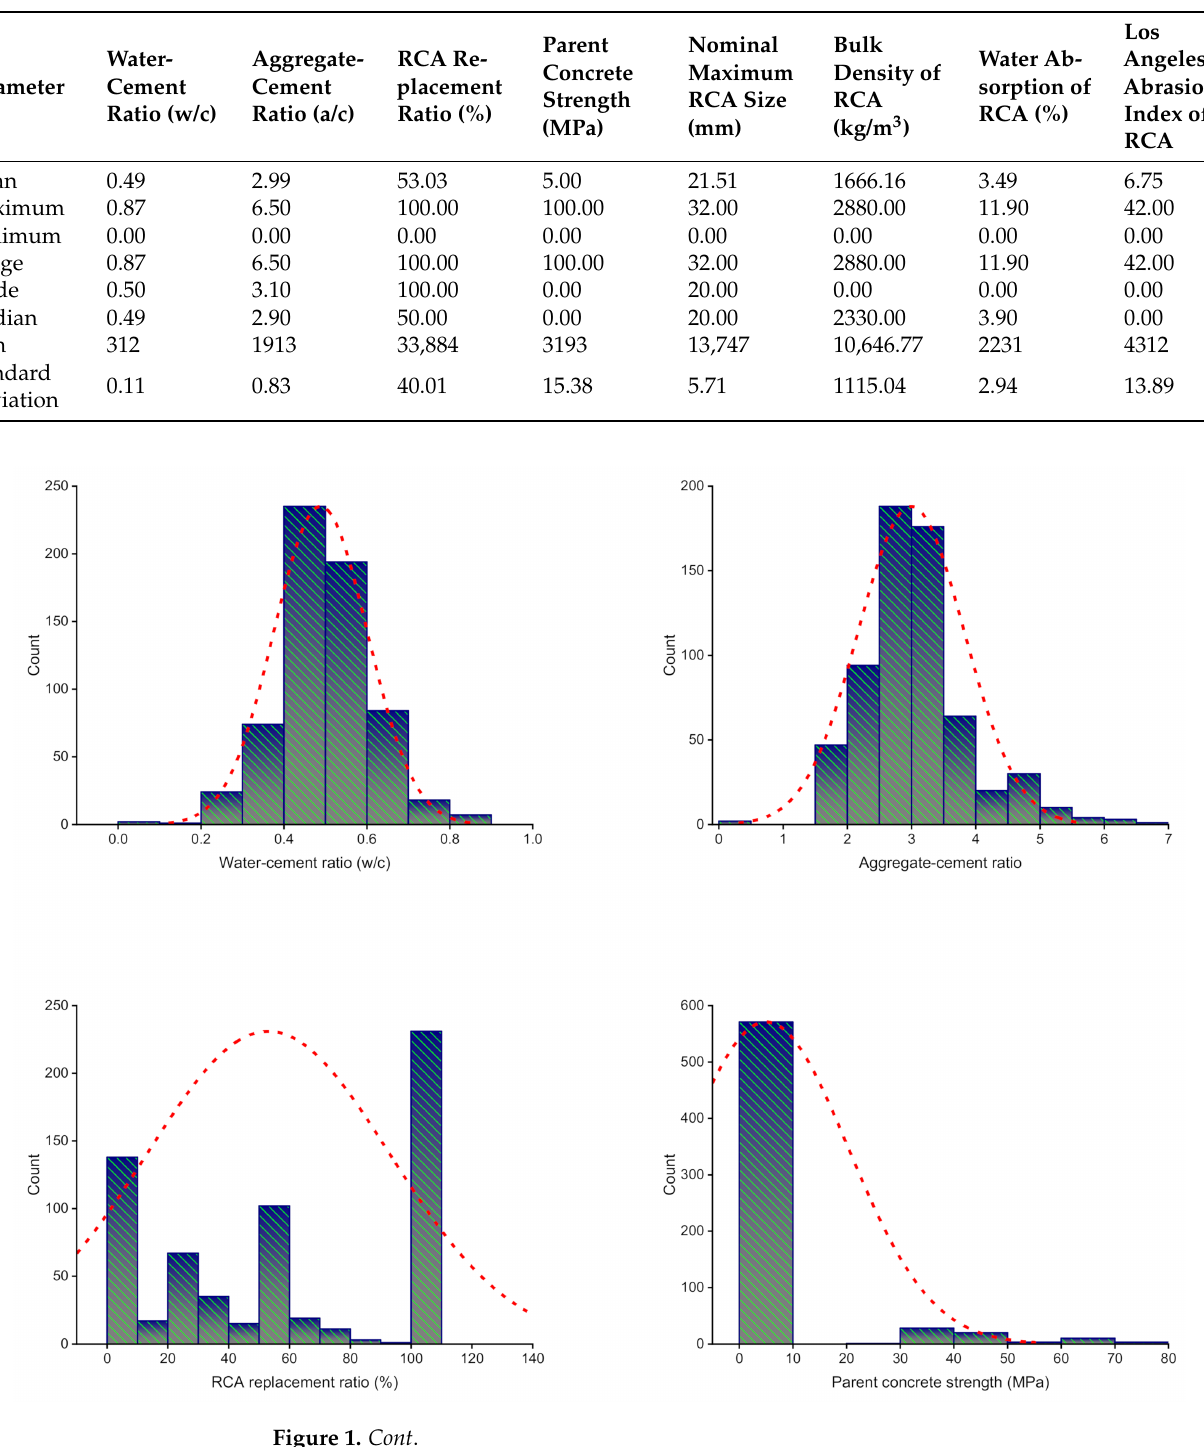
Table 1. Descriptive assessment results of input factors used.